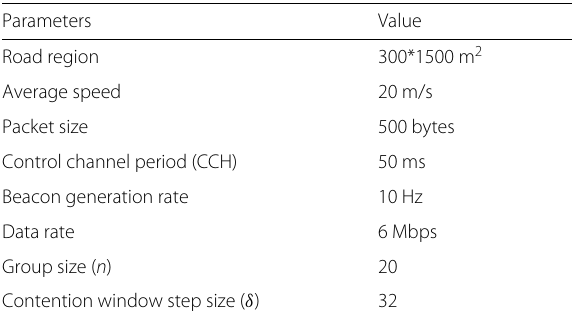
Table 3 Parameters in simulation